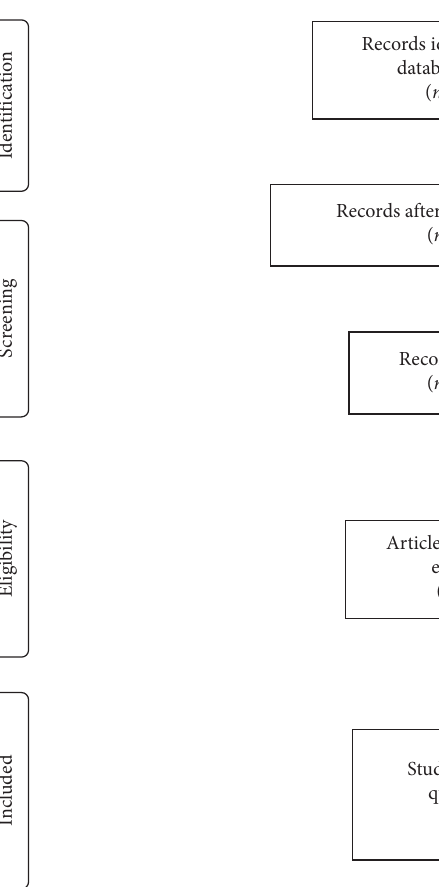
Figure 1: PRISMA LAAO in intracranial